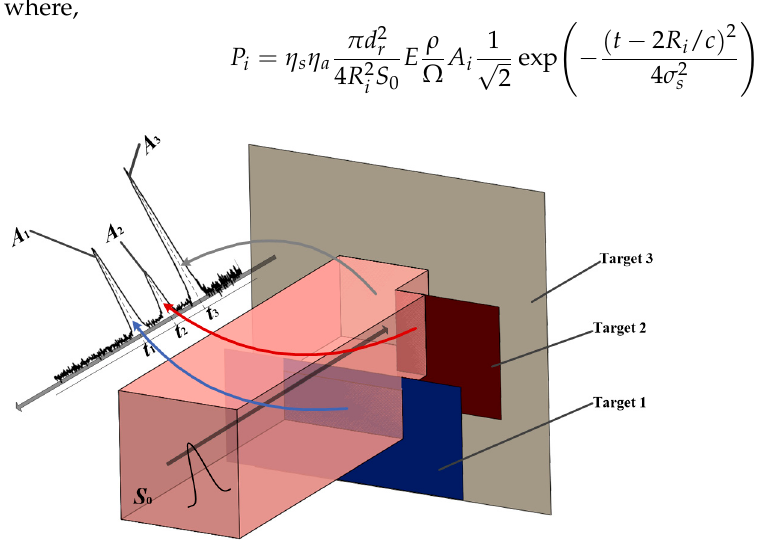
Figure 1. TOF measurement of multi-target.